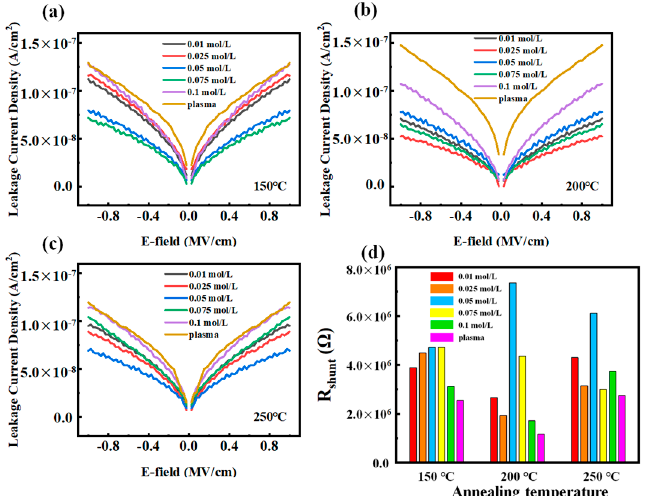
Figure 9. Zr–AlO x film leakage current at different annealing temperature: ( a ) 150 °C, ( b ) 200 °C, ( c ) 250 °C; ( d ) shunt resistance of films aforementioned.